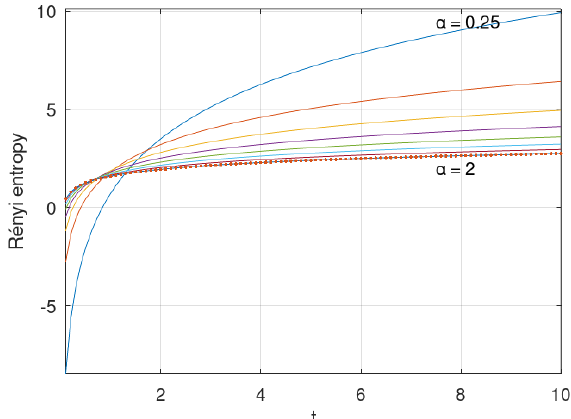
Figure 3. Rényi entropy (41) as function of the order, α , for t = 2 n , n = − 2, − 1,0,1,2, with θ =